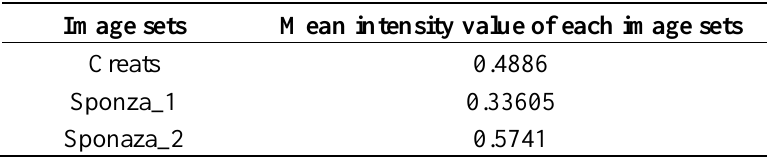
Table 8. Average of image intensity